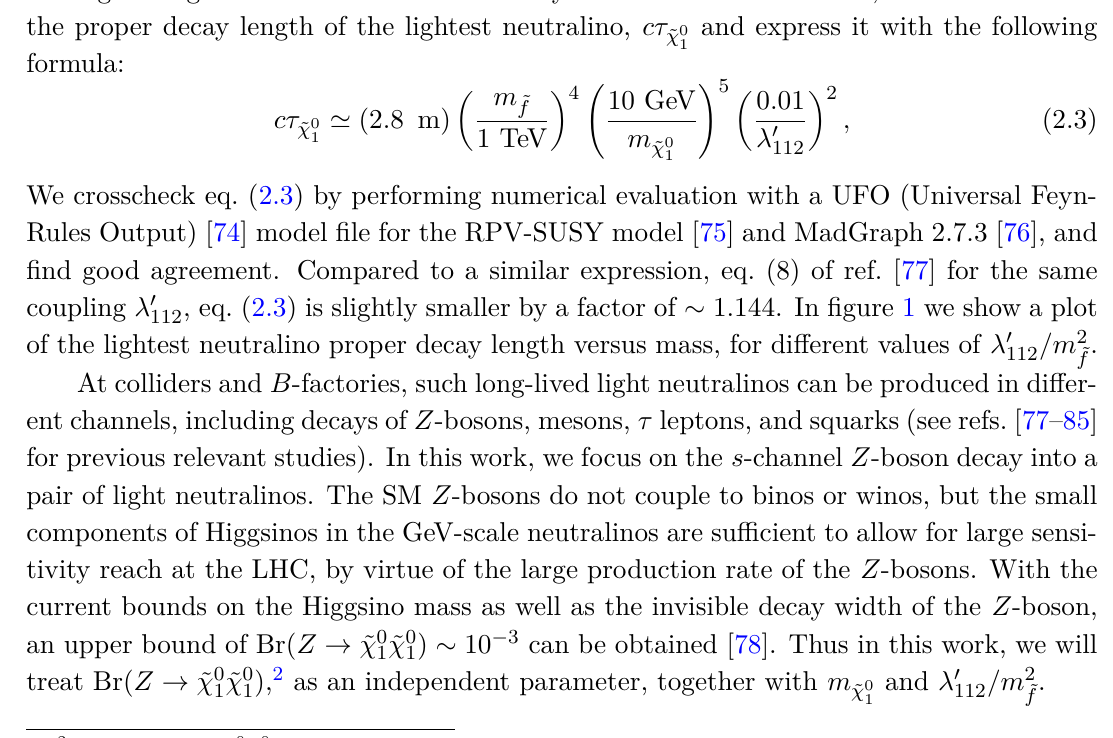
vs. m , for various values of λ 0 ˜ χ 0 1 ˜ χ 0 1